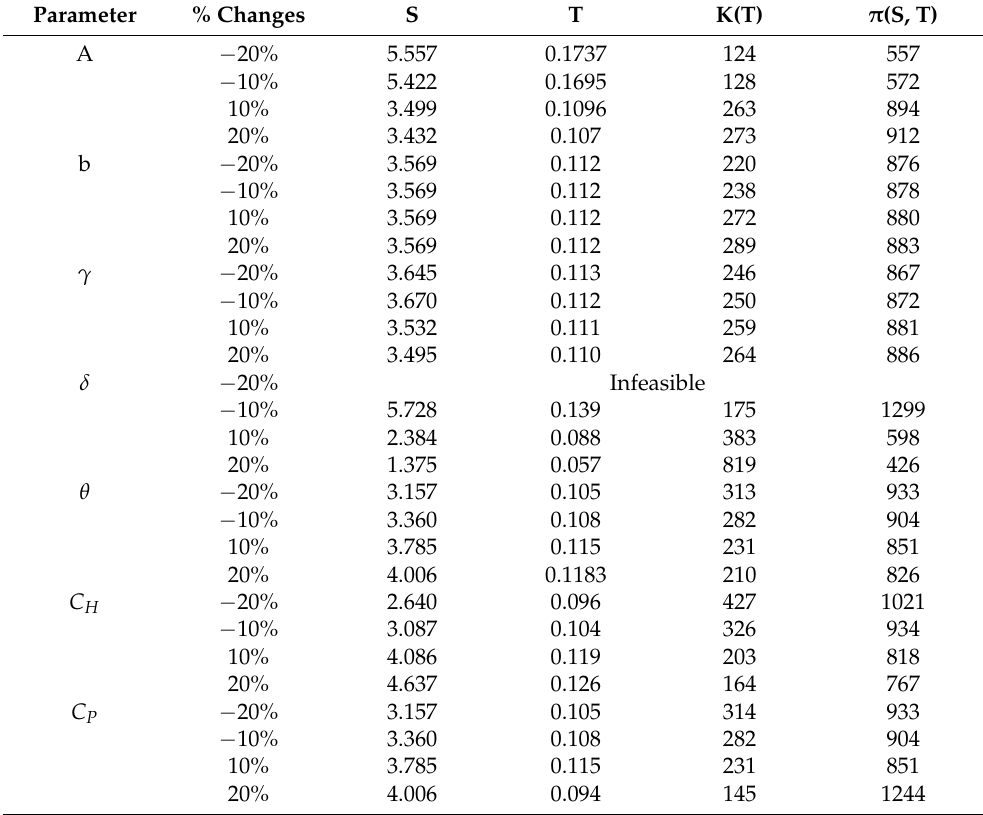
Table 4. Sensitivity analysis.